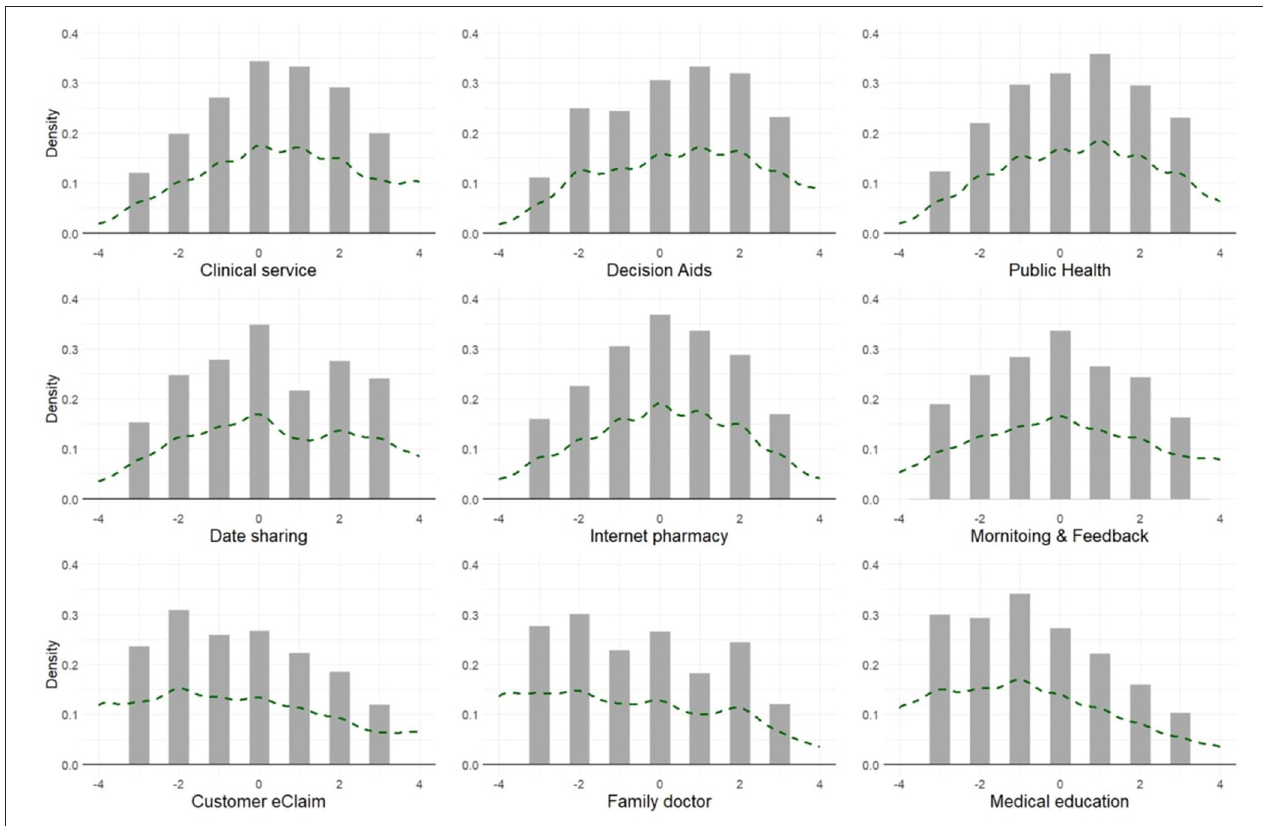
FIGURE 2 | The score distribution of the BWS attributes.